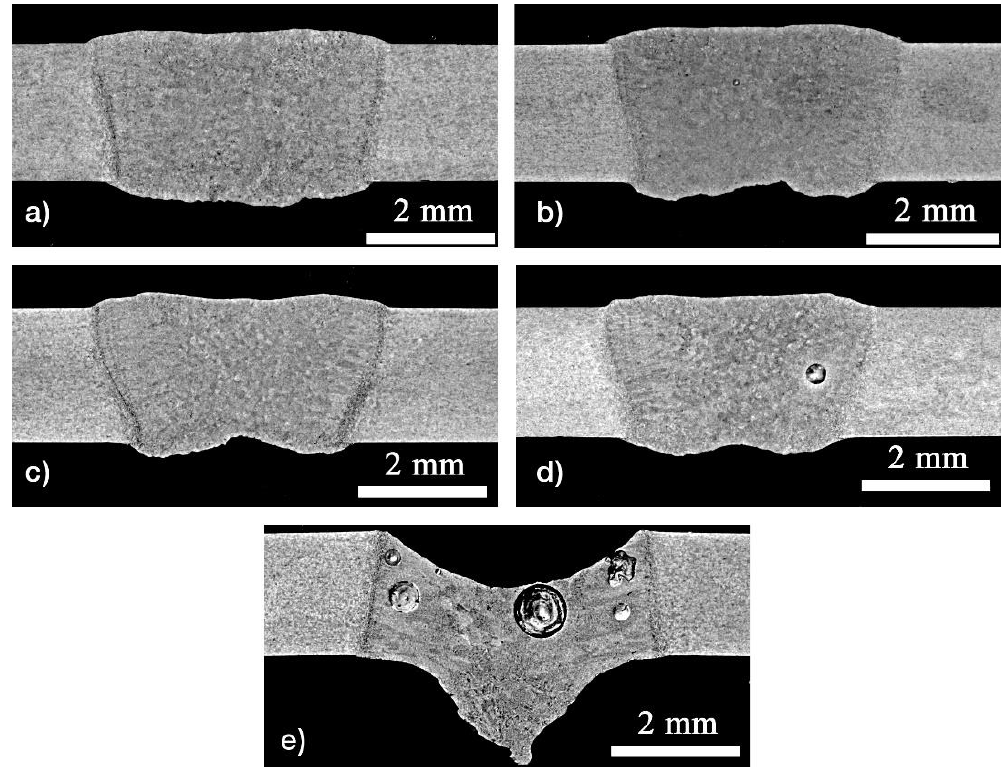
Figure 3. Cross-sections of the welds at the following gas flow rates (L/min): ( a ) 30 ; ( b ) 24 ; ( c ) 18 ; ( d ) 12 ; ( e ) 0. Images were captured on a camera with a macro objective.